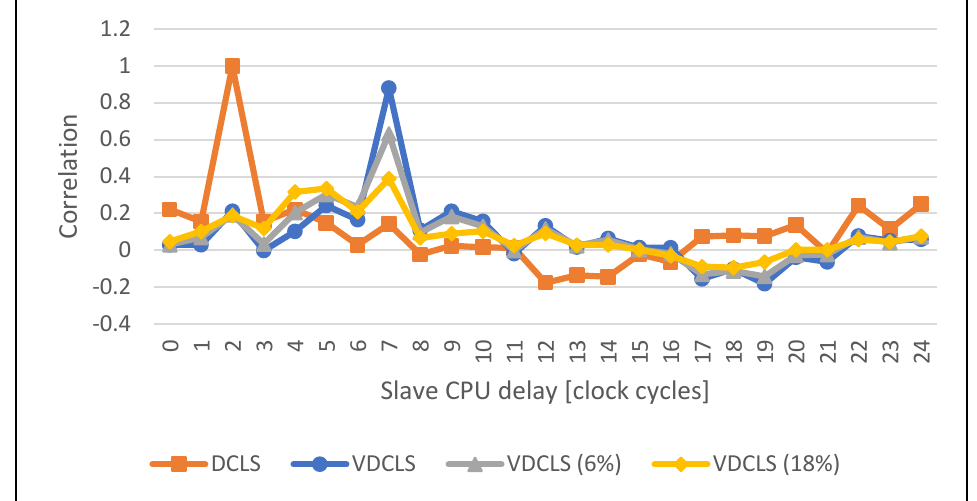
Figure 16. Comparison of the execution correlation between master and slave CPUs using VDCLS with dummy cycles insertion and legacy DCLS technique while executing the CMAC-AES algo- rithm.